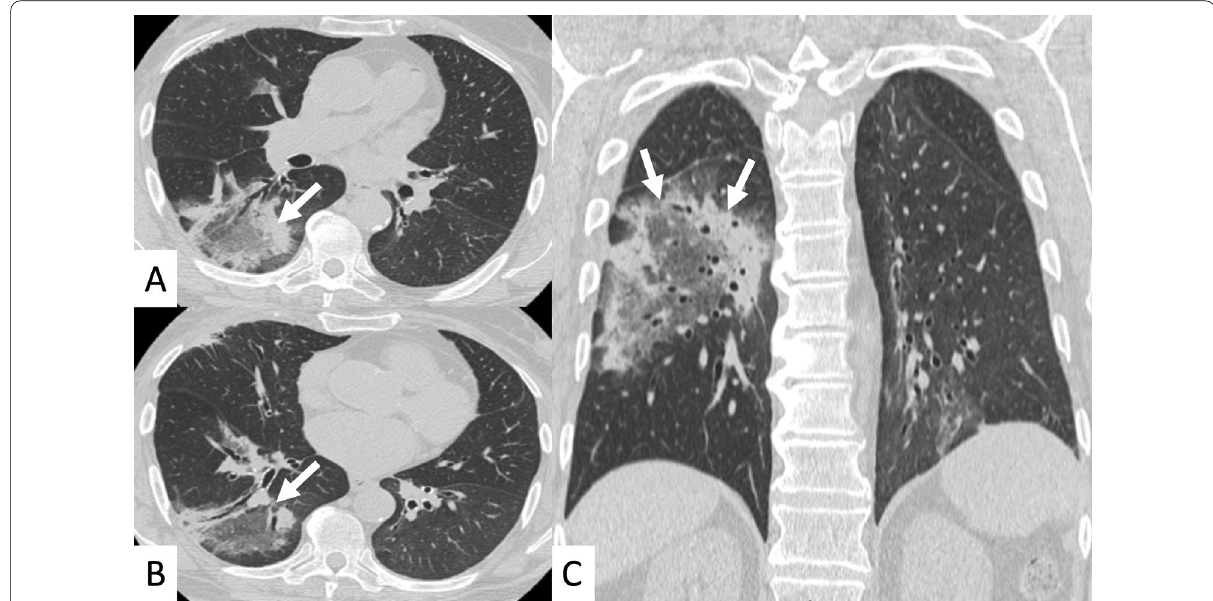
Fig. 19 Reverse halo sign or “atoll sign” in a patient with OP. HCRT images show circular consolidations surrounding normal parenchyma (white arrows in A – C